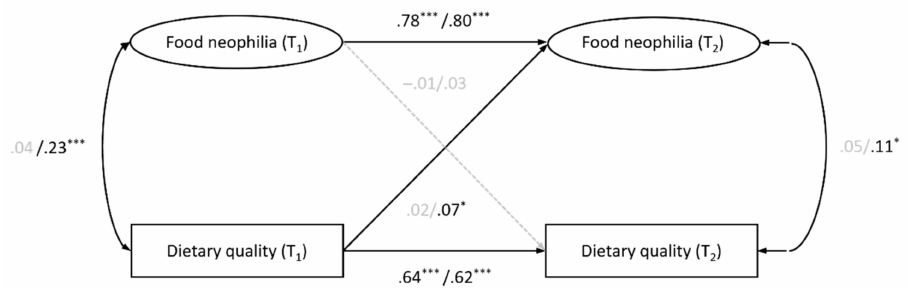
Figure 2. Temporal stability and reciprocal effects of food neophilia and dietary quality for individuals with normal weight ( n = 429, named first) and with overweight/obesity ( n =